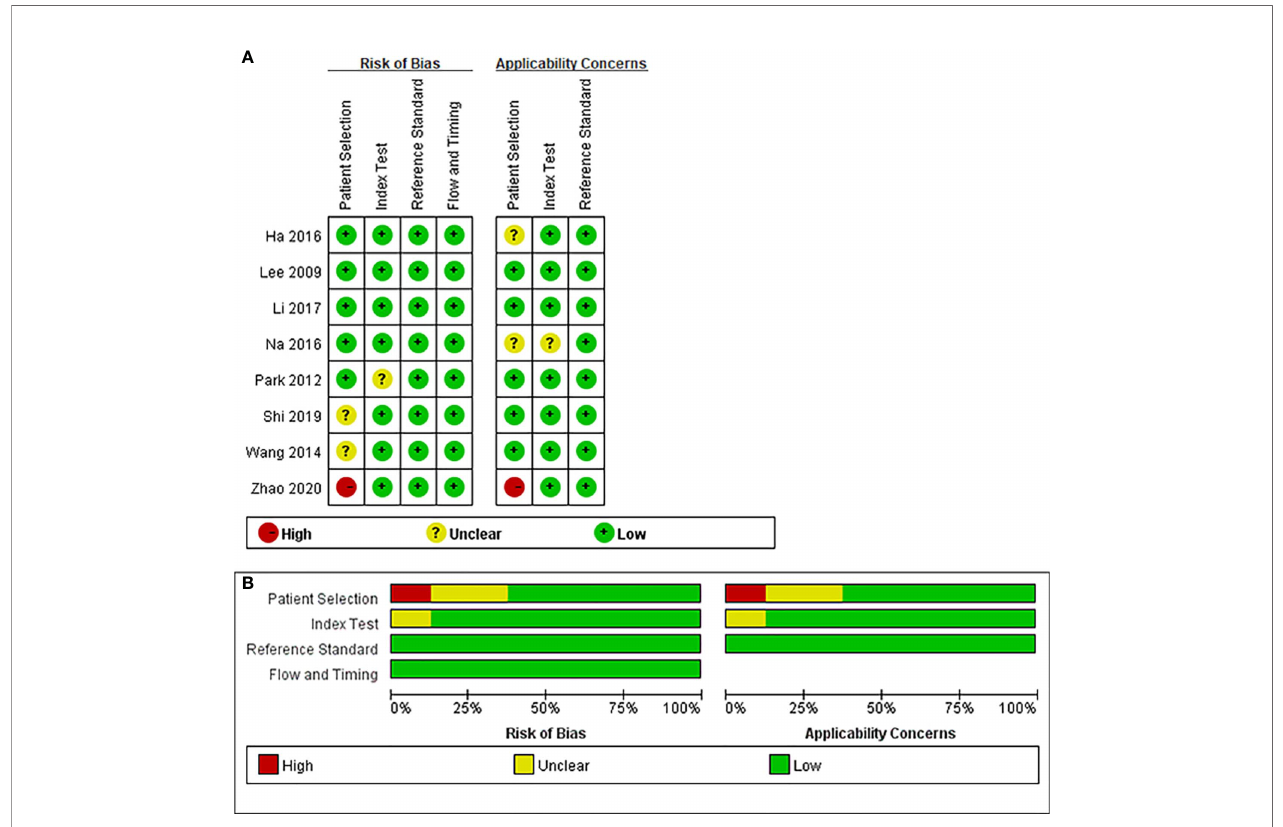
FIGURE 2 | Outcome of QUADAS-2 for included studies. (A) Risk-of-bias summary. (B) Risk-of-bias graph. Symbols: (+), low risk of bias; (?), unclear risk of bias; (-), high risk of